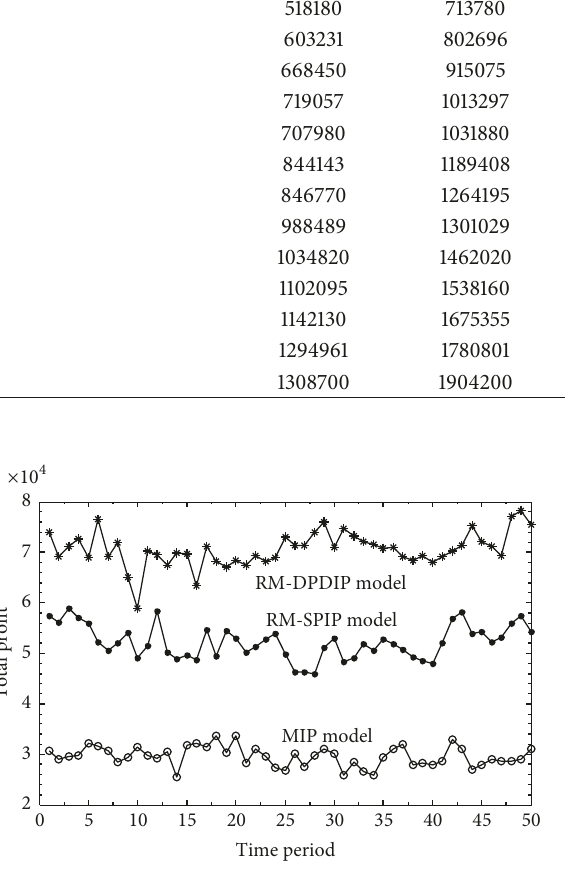
Figure 3: Comparison of models RM-DPDIP, RM-SPIP, and